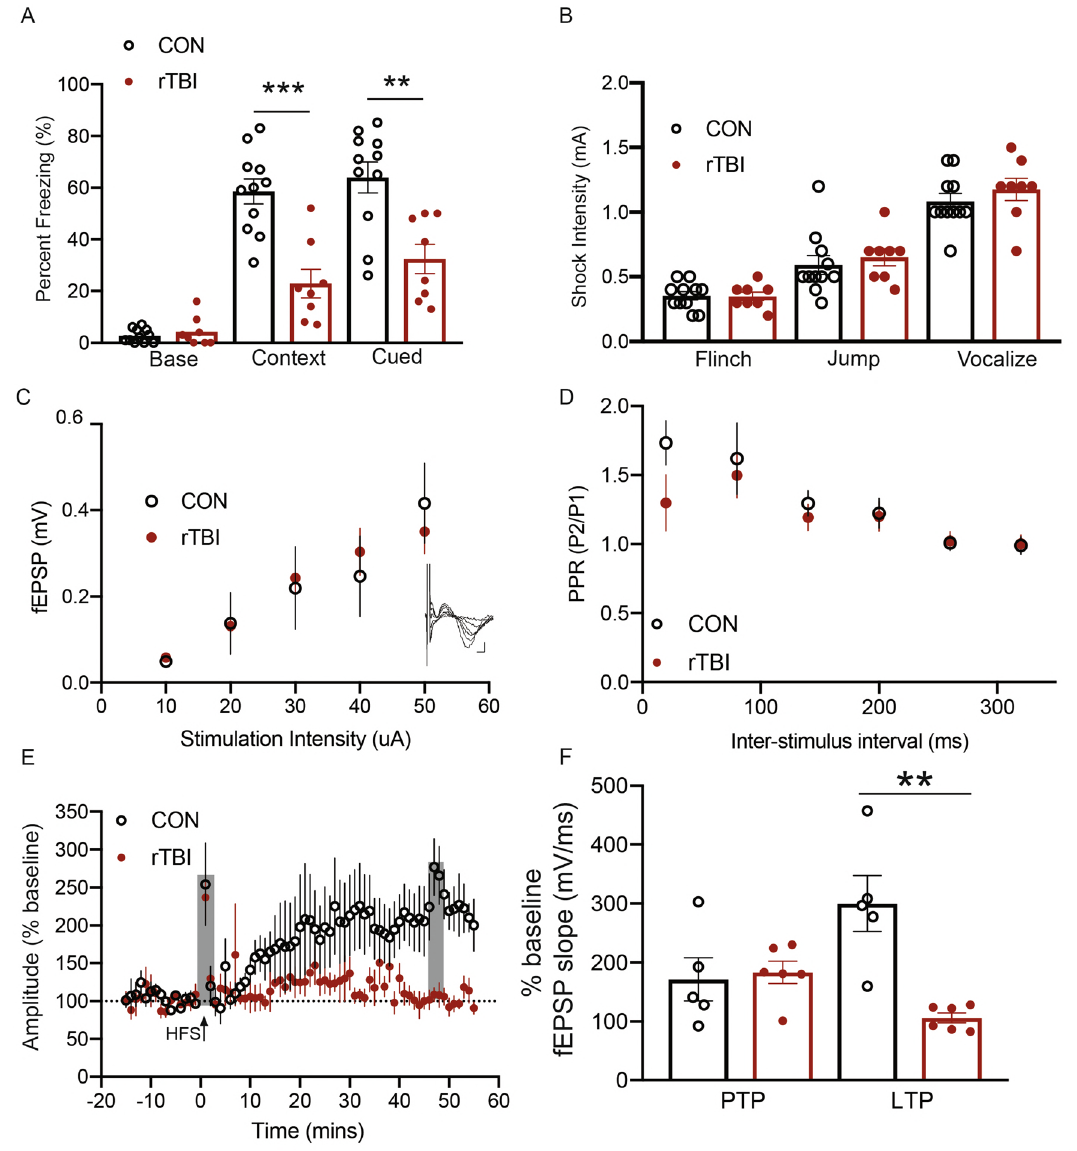
Figure 3. Behavioral and neurophysiological consequences of rTBI. ( A ) Fear conditioning freezing rates for baseline, Contextual, p = 0.0001 Student’s t -test, and Cued, p = 0.0018 Student’s t -test fear learning (n = 8–11 per group). ( B ) Shock sensitivity thresholds to flinch, jump, or vocalize pain (n = 8–11 per group). ( C ) Input–Output curve of CA3-CA1 fEPSP recordings (Inset: individual traces for each of the stimulus intensities) (n = 5–6 per group). ( D ) Paired Pulse Ratio (PPR) across inter-stimulus interval (n = 5–6 per group). ( E ) Assessment of the effect of rTBI on hippocampal plasticity after HFS (n = 5–6 per group). (PTP outlined grey 0–2 min, LTP outlined grey 45–55 min). ( F ) Summary of PTP and LTP fEPSP slopes, (n = 5–6 per group) p = 0.7662, PTP; p = 0.0017, LTP Student’s t -test. All data are means ± SEM, * p < 0.05, ** < 0.01, *** <